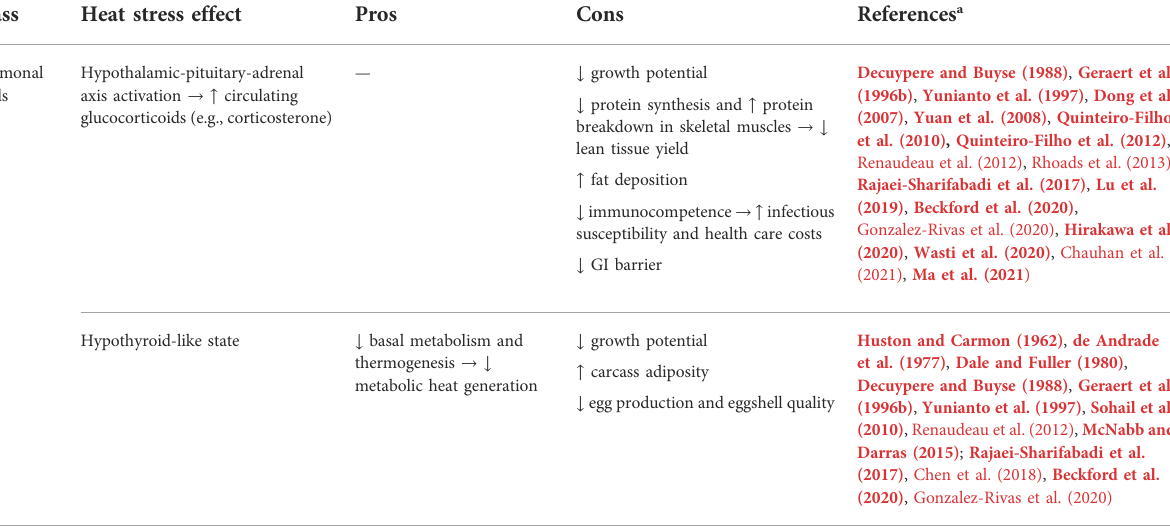
TABLE 4 Overview of heat stress effects on chicken hormonal